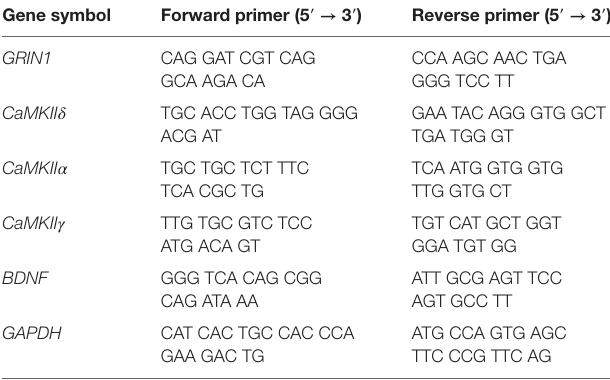
TaBle 1 | Primers used for